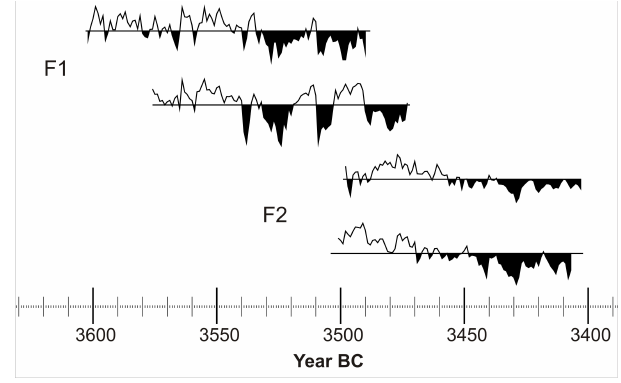
Figure 10. Tree-ring-width curves of chronology segment F. The mean value of the tree ring widths is indicated by a horizontal line for each curve; the area below mean is filled black to highlight growth depressions. One sample is not shown because it is miss- ing several rings to bark and therefore the record of the final years of that tree’s life. All trees show narrow ring widths prior to their deaths. These growth depressions are not reflected equally in the surviving trees. This illustrates the locality of the